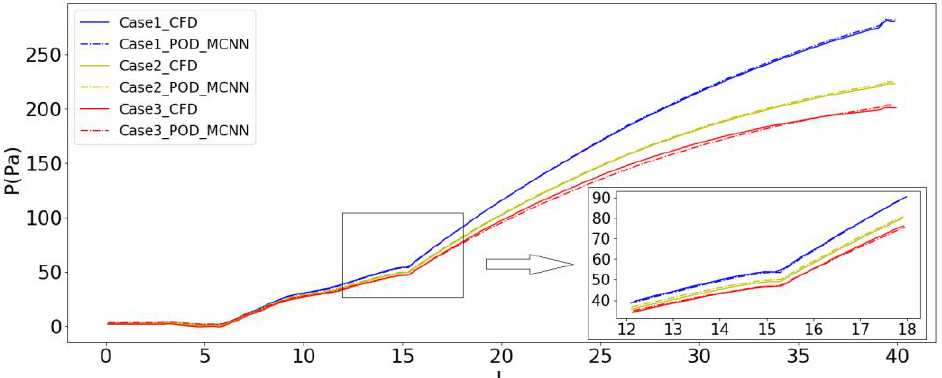
Figure 14. Temperature trend prediction results for three cases on new data.